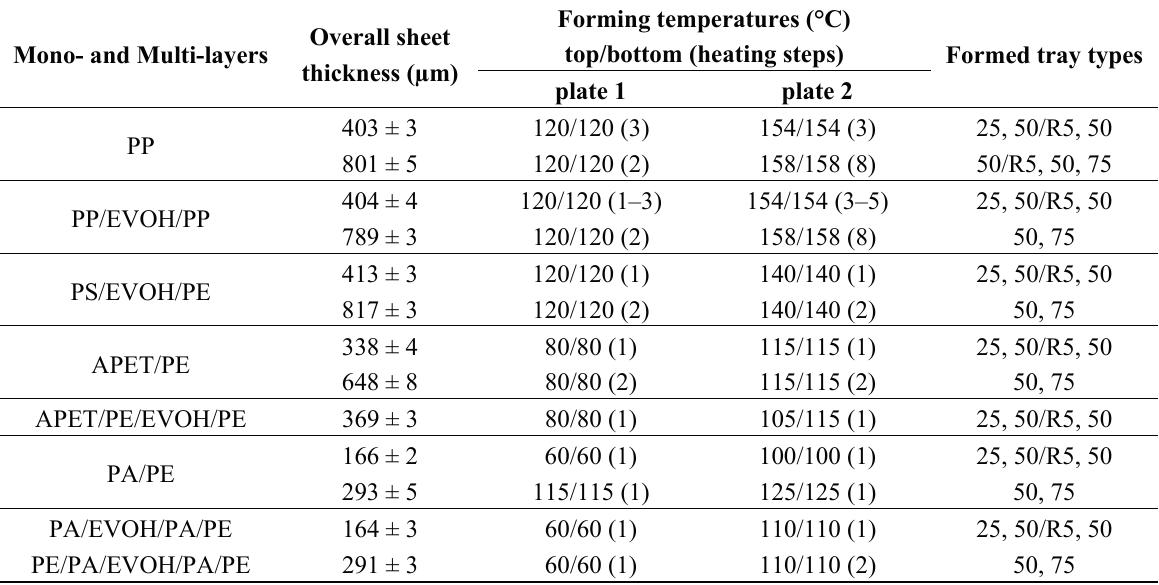
Table 2. Overview of processing parameters and formed tray types for each test material. Mono- and